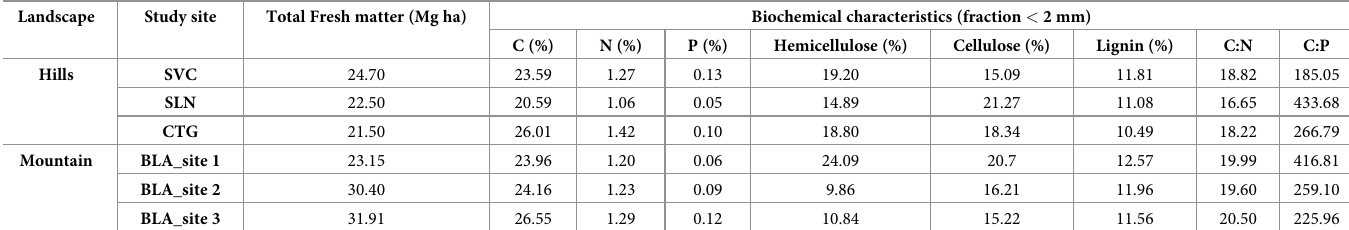
Table 2. Fresh matter and biochemical characteristics of forest litter layer from Colombian Amazon region. Landscape Study